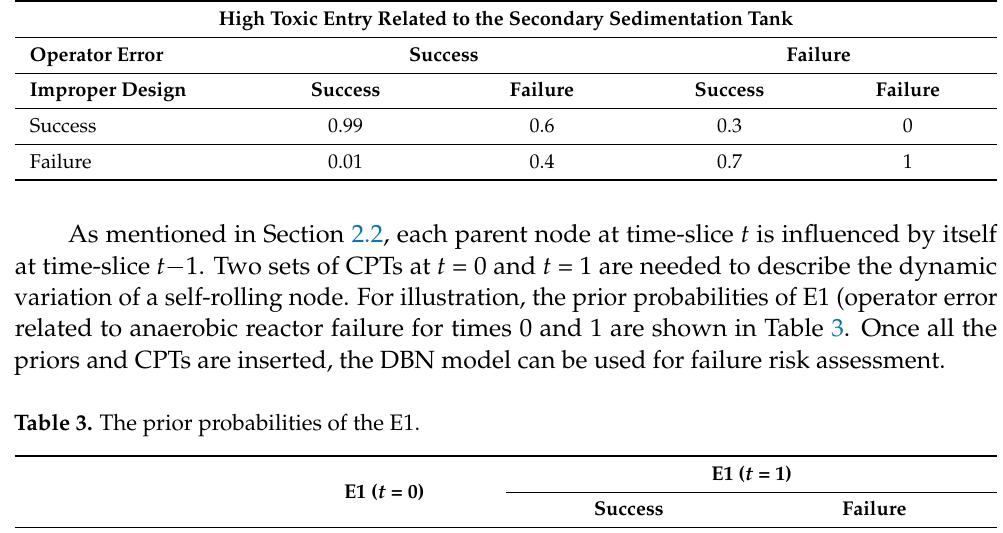
Figure 8. The DBN model of the MIC WWTP (part 3).